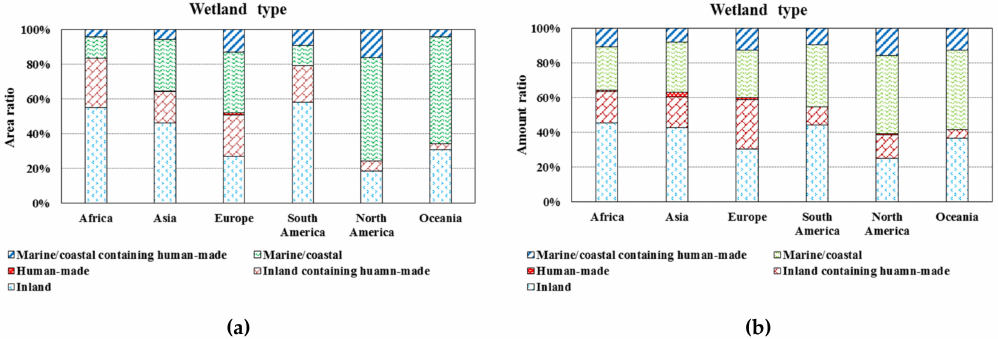
Figure 2. The area ratio ( a ) and amount ratio ( b ) of di ff erent wetland types in each continent. The data source of Figure 2 is the Ramsar o ffi cial website. For details, see Reference